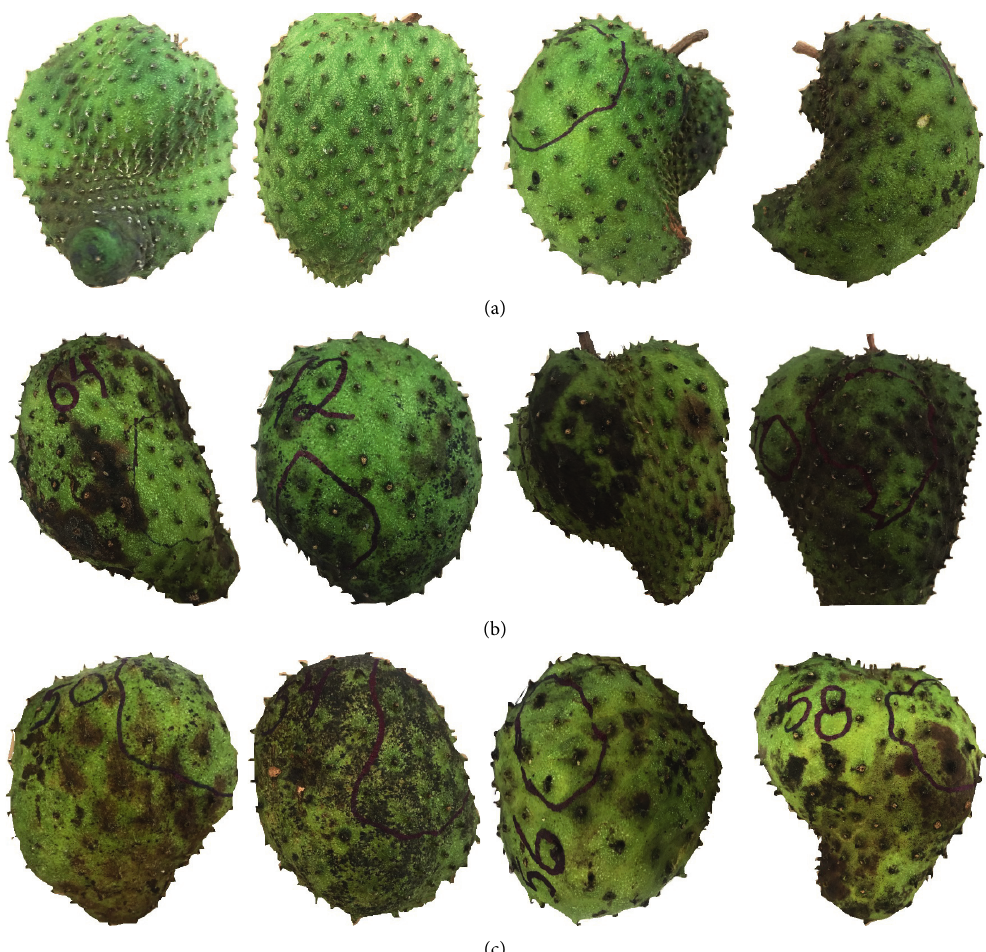
Figure 1: Soursop fruits stored for three days at 28 ± 2 ° C and 95% RH. Control fruits (a) and fruits treated with C. siamense (b) and C. gloeosporioides (c).